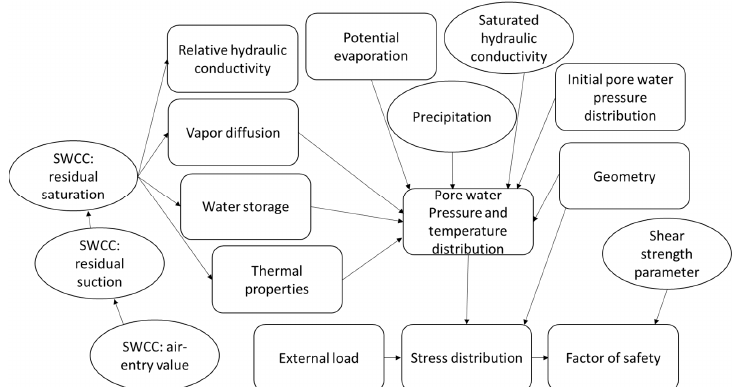
Figure 9. Unsaturated soil variables effect on transport infrastructure slope stability (modified after Gitirana [63])